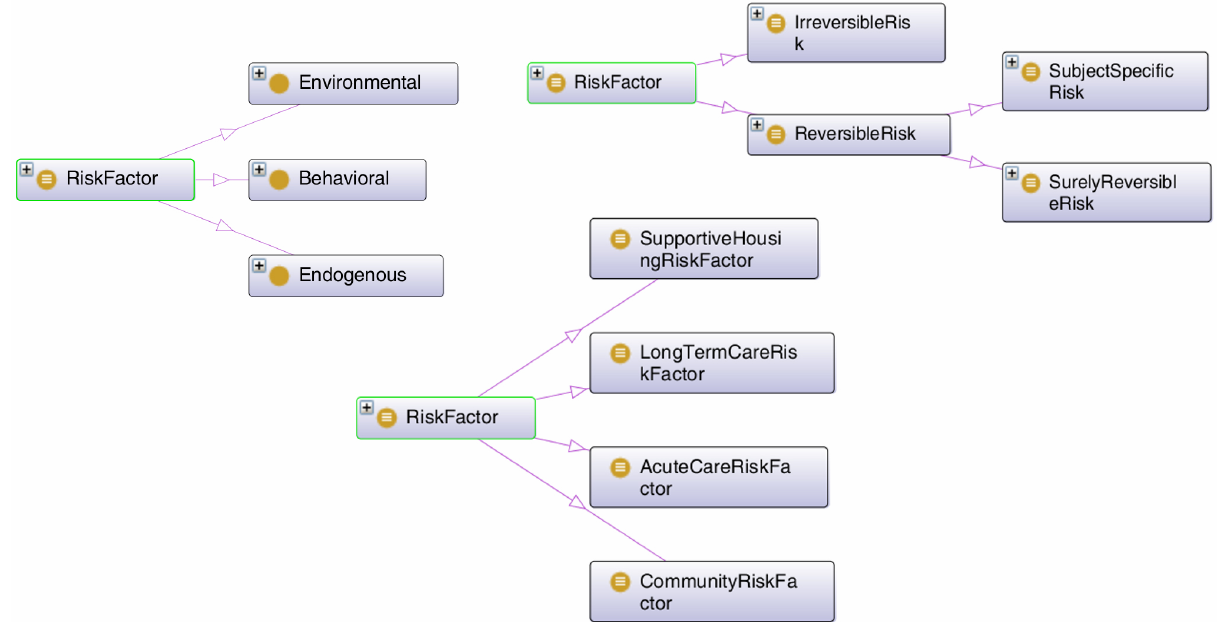
Figure 1. Classification of risk factors by kind, reversibility, and setting. While the InCHIANTI dataset is about community dwellings, the ontology covers other settings,